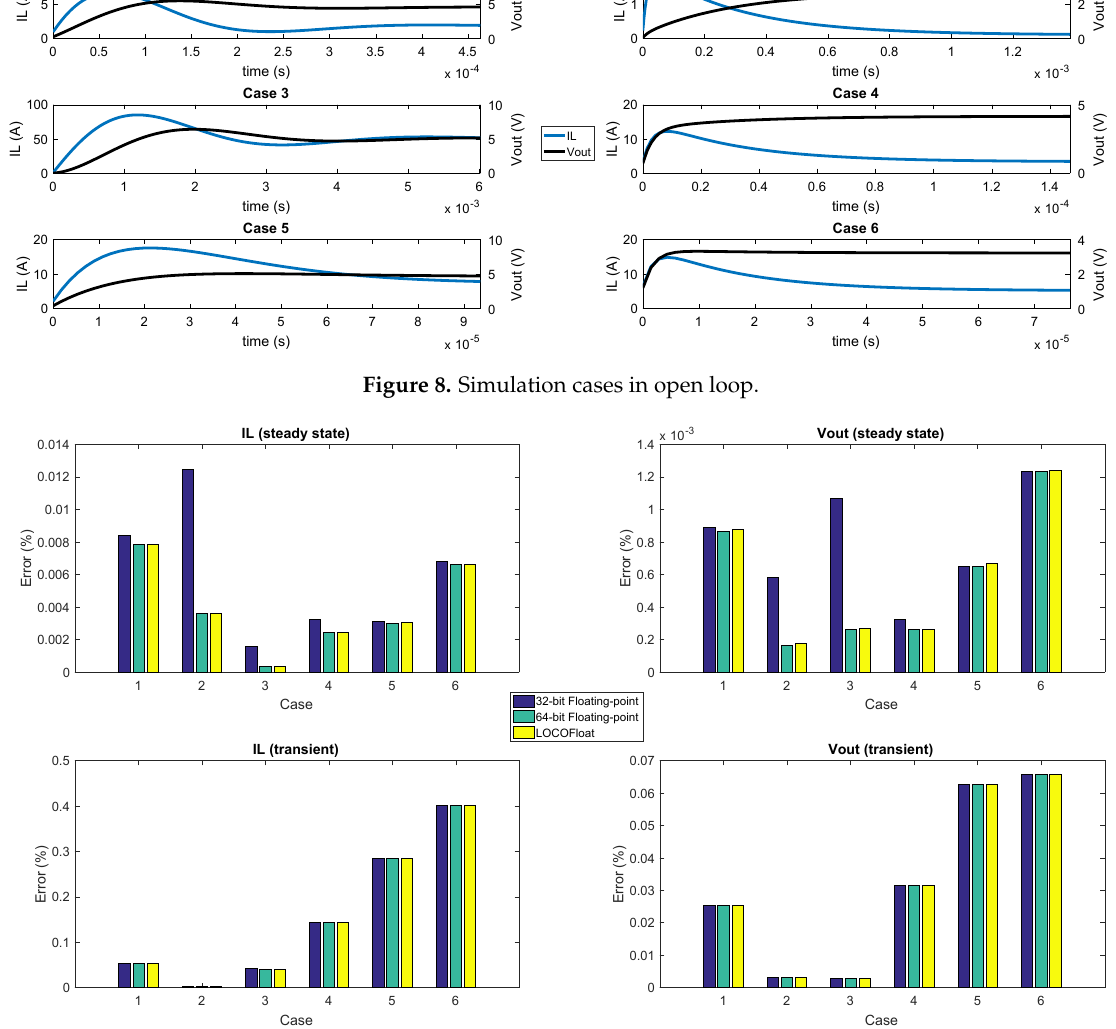
Figure 9. Accuracy results for all the arithmetics using a simulation step of 40 ns. Percentage error related to the reference